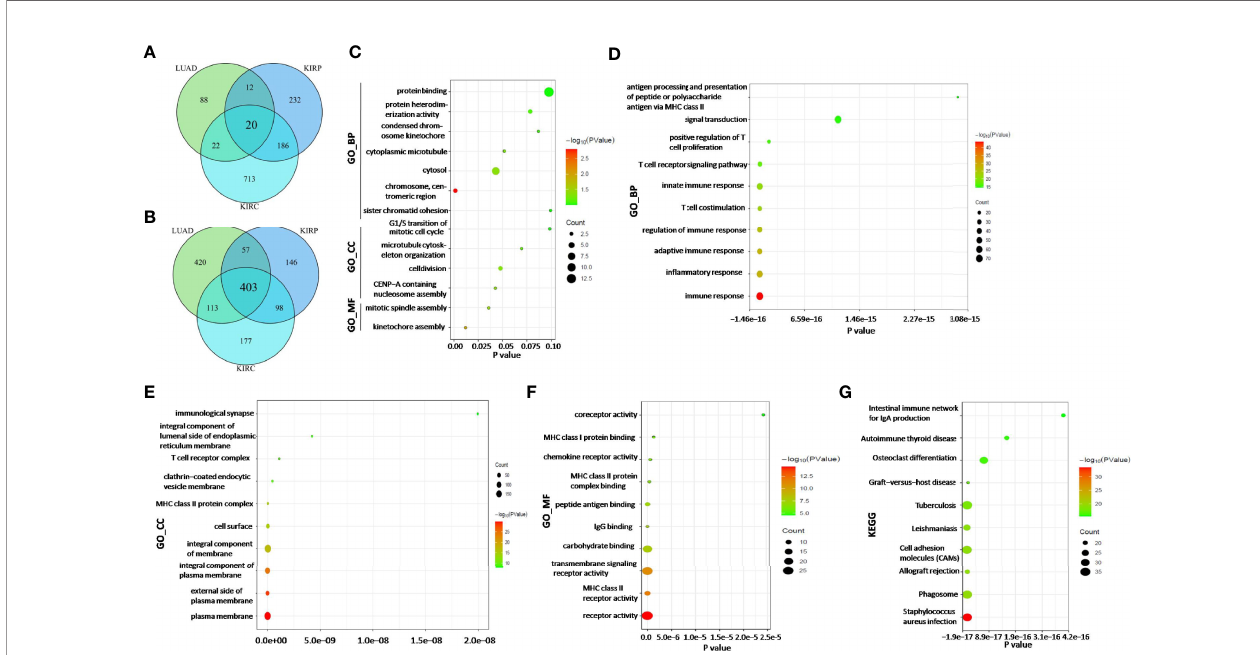
FIGURE 7 | ADA1 and ADA2 expression-related genes and function analysis. (A) The shared gene signature positively correlated to ADA1 expression among LUAD, KIRP, and KIRC. (B) The shared gene signature positively correlated to ADA2 expression among LUAD, KIRP, and KIRC. (C) Function enrichment analysis of shared ADA1-related genes (n = 20). (D – G) Function enrichment analysis of shared ADA2-related genes (n = 403). TCGA, The Cancer Genome Atlas; LUAD, lung adenocarcinoma; KIRP, kidney renal papillary cell carcinoma; KIRC, kidney renal clear cell carcinoma.